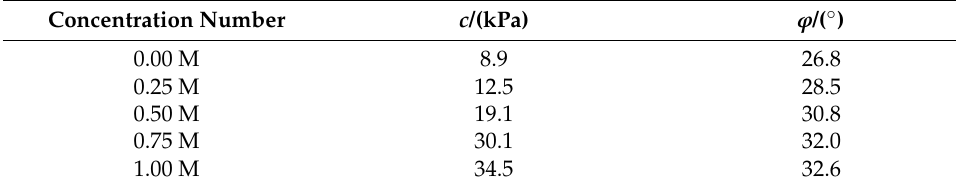
Table 3. Mechanical parameters of shear strength.